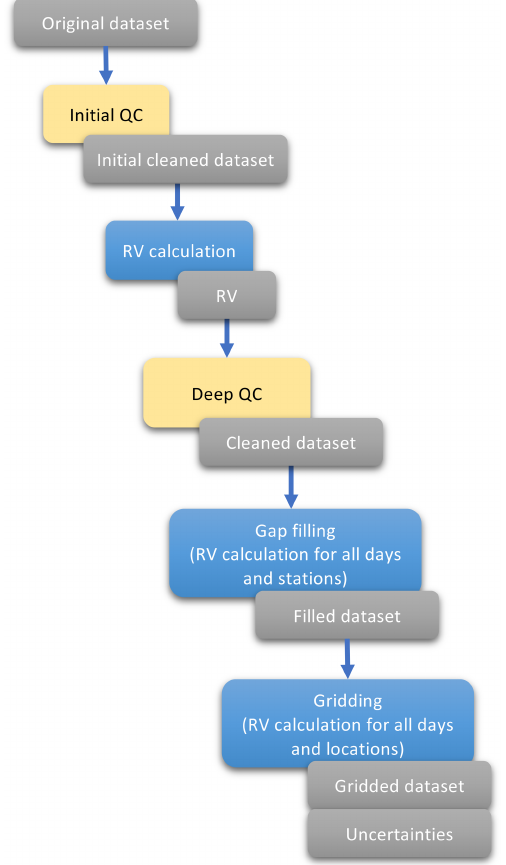
Figure 3. Methodological protocol in a nutshell. Grey boxes repre- sent products, yellow boxes are correction processes and blue boxes involve reference value (RV)